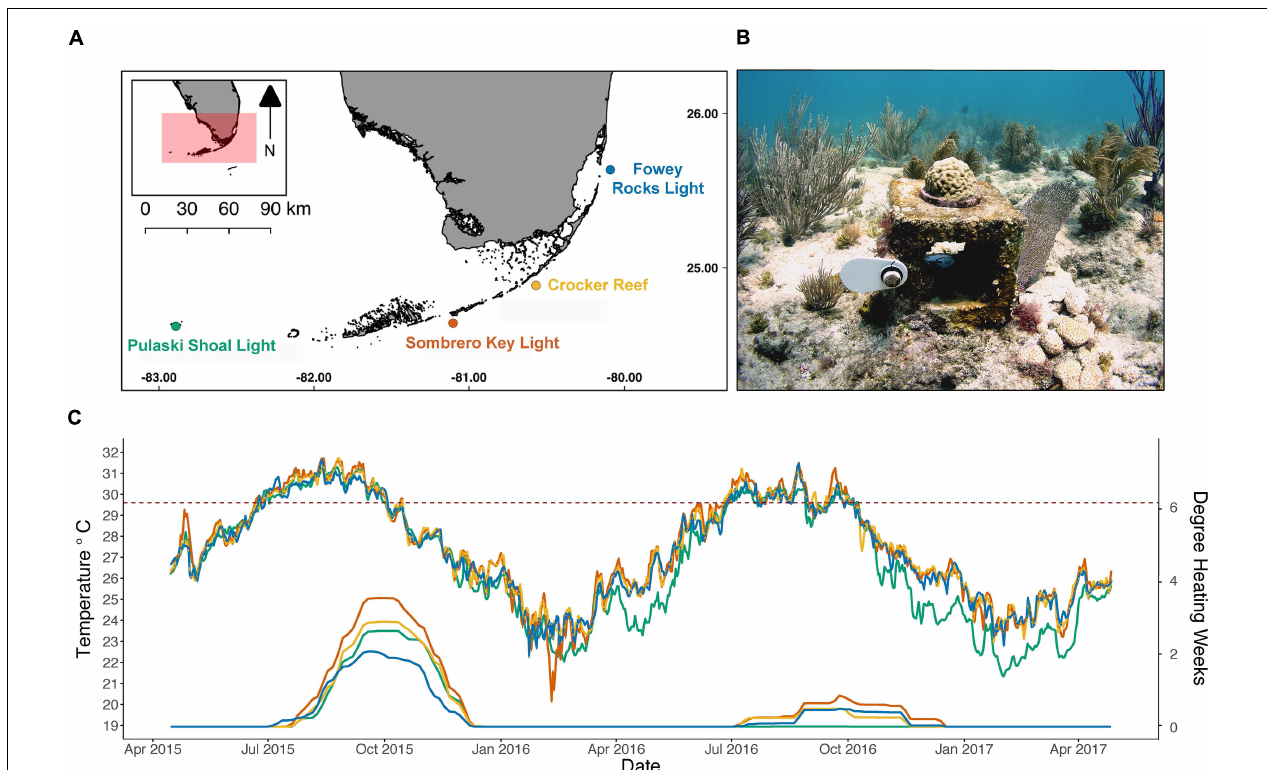
FIGURE 1 | (A) Map of sites established by the U.S. Geological Survey for the calcification assessment network along the Florida Key Reef Tract, with Pulaski Shoal Light (green) in Dry Tortugas National Park, Sombrero Key Light (orange) in the middle Keys, Crocker Reef (yellow) in the southern upper Keys, and Fowey Rocks Light (blue) in the northern upper Keys in Biscayne National Park. (B) Underwater photograph (image by I.B. Kuffner) of one of the 40 calcification stations with a Porites astreoides colony fastened to the top. The cement block is 19 × 19 × 19 cm for scale. (C) Mean daily temperature (top, left axis) at each site with a red dashed line indicating the 29.6_C maximum monthly mean in the Florida Keys (Manzello et al., 2015) and degree heating weeks calculated using climatology specific to each respective site (bottom, right